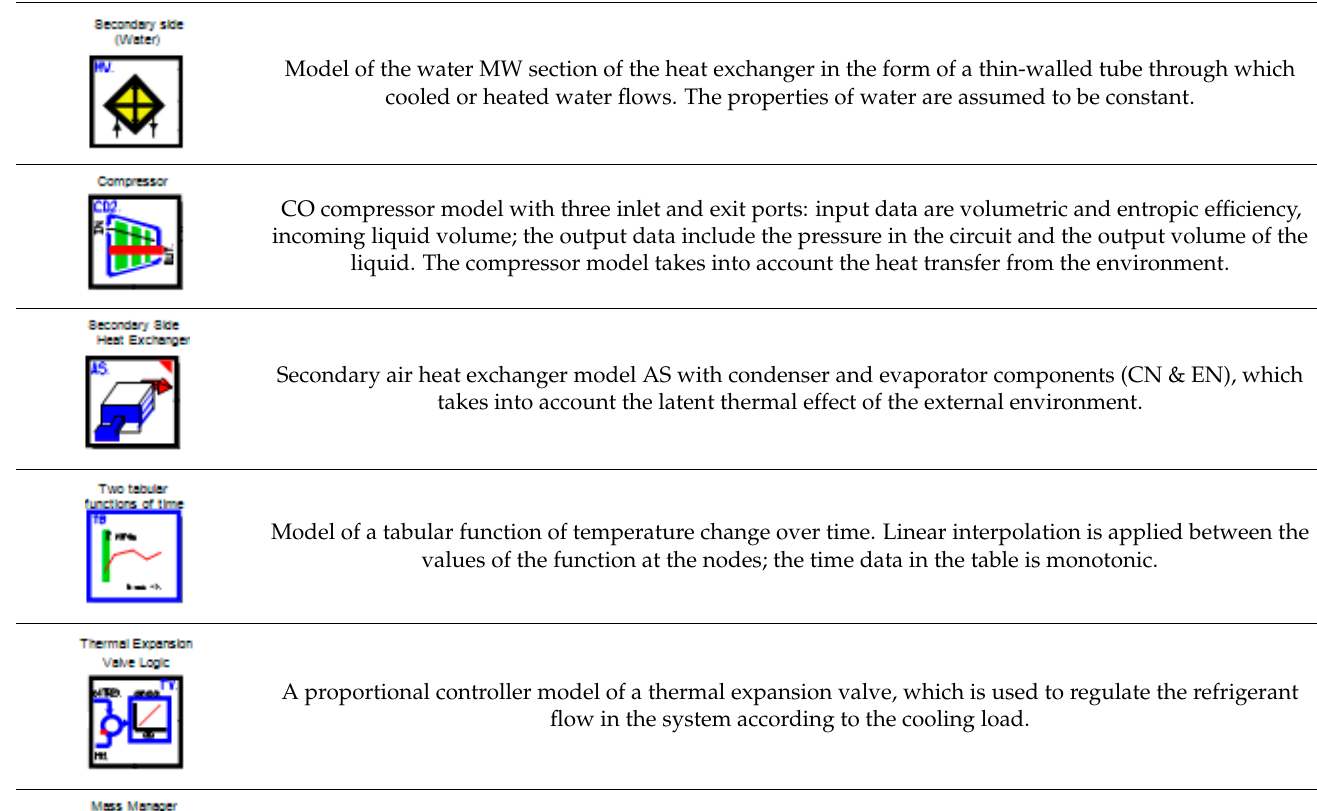
Table 1. Functions of a prototype device in a temperature control model.